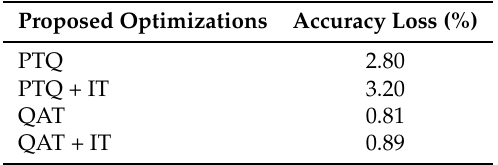
Table 1. Accuracy loss w.r.t. quantization and thresholding.